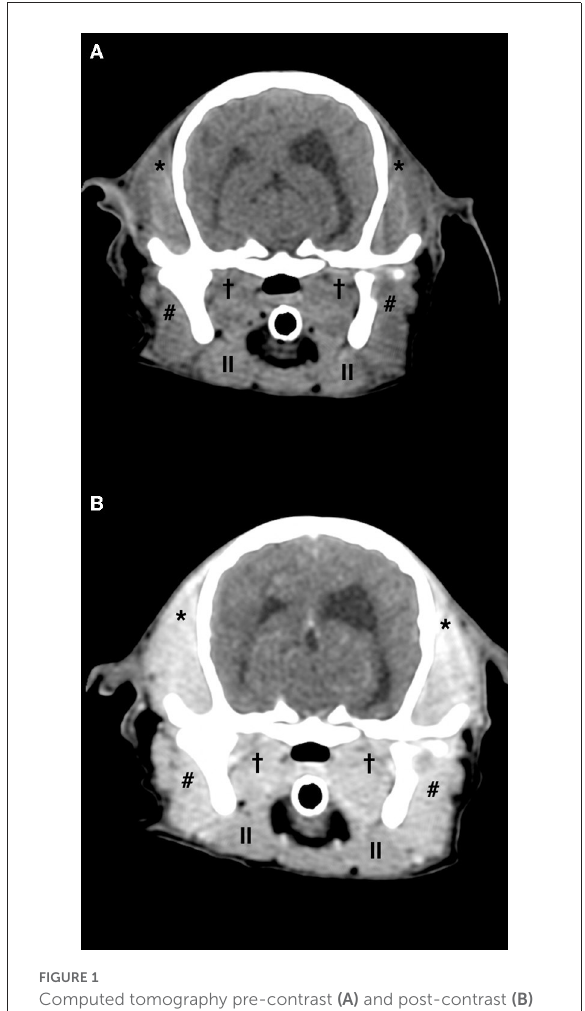
FIGURE1 Computed tomography pre-contrast (A) and post-contrast (B) images of the head of a 5-month old Cavalier King Charles Spaniel affected by masticatory muscle myositis. Note the severe, diffuse, and bilateral atrophy of temporalis, masseter, and pterygoid muscles and contrast enhancement of the masticatory muscle in post-contrast image (* temporalis muscle, # masseter muscle, † pterygoid muscle, || digastricus